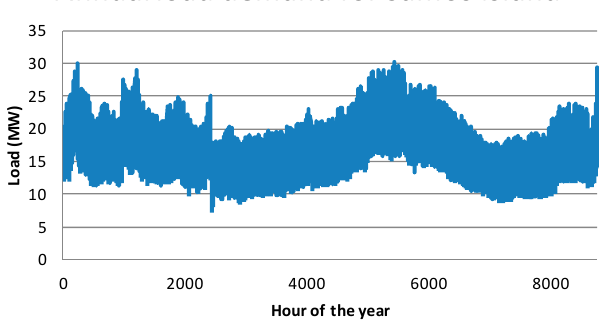
Figure 3. Annual net load demand variation for Samos Island (2015).